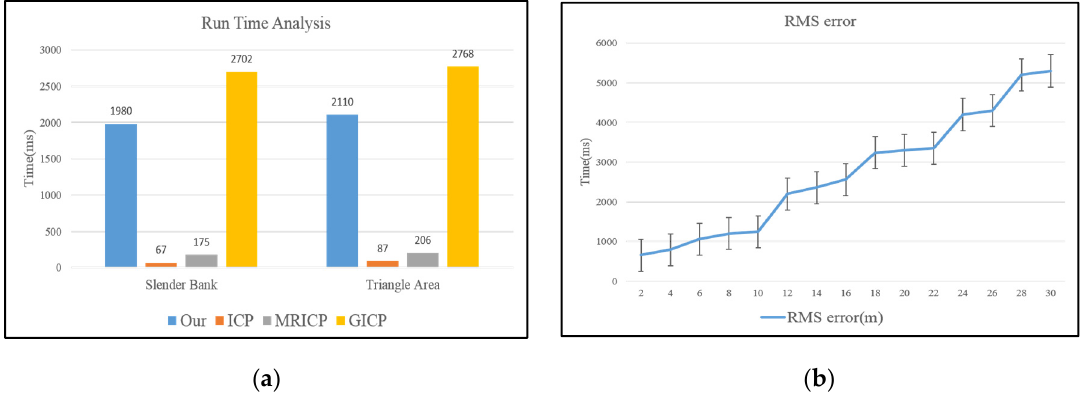
Figure 11. Time cost analysis: ( a ) in both Slender Bank test and Triangle Area test, our method could make the alignment around 2 s, faster than the generalized ICP, but slower than the standard-ICP method and multi-resolution ICP method because of the heuristic escape scheme; ( b ) the registration time is highly related to RMS error.